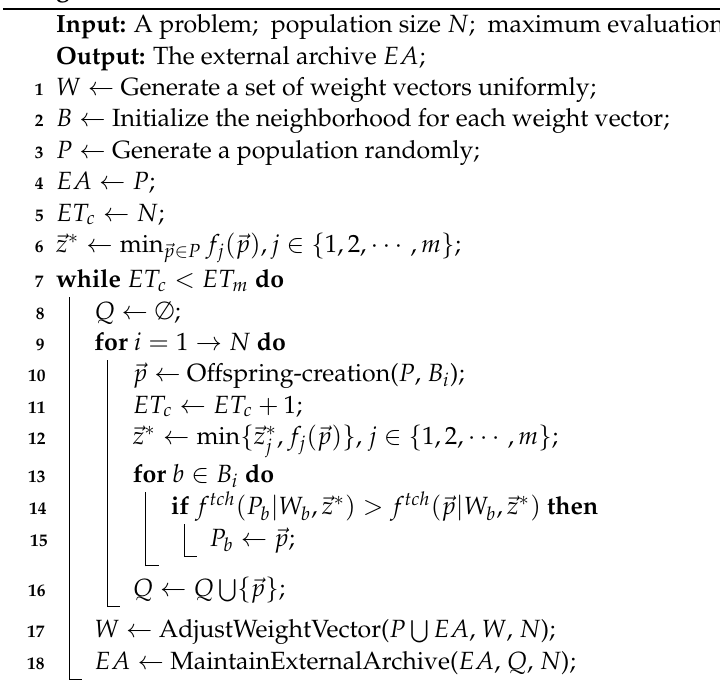
Algorithm 1: Main framework of